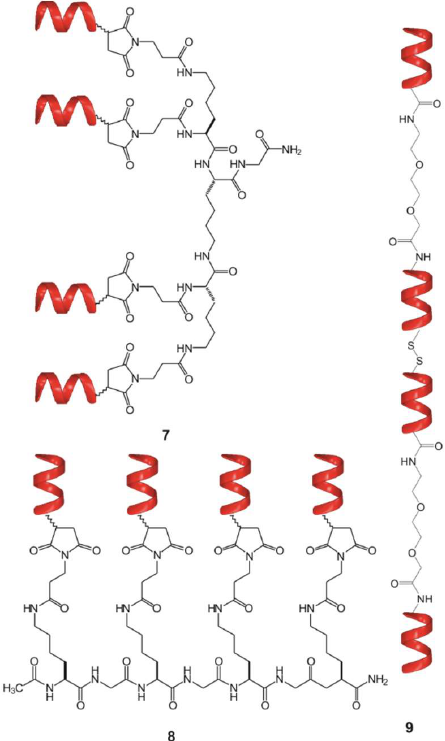
Figure 4. Tetrameric foldamer conjugates with different topology of interaction: focal symmetry ( 7 ), linear, foldamers are connected in parallel ( 8 ), linear tetramer ( 9 ).